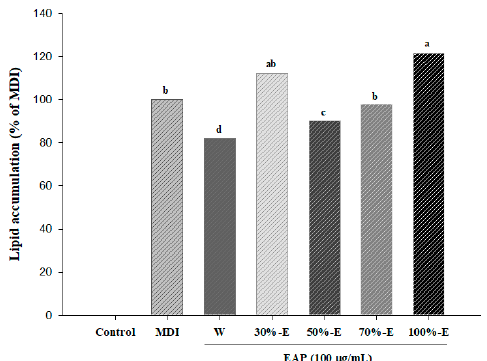
Figure 1. Effects of various extracts of EAP on lipid accumulation in 3T3-L1 adipocytes. EAP: Erigeron annuus (L.) Pers. water extract, Post-confluent 3T3-L1 preadipocytes were differentiated in the presence of various EAP extracts (water, 30% ethanol, 50% ethanol, 70% ethanol and 100% ethanol) for seven days. Lipid accumulation of cells was determined by Oil Red O (ORO) staining followed by reading absorbance at 490 nm. Values are presented as mean ± standard deviation. Differences between means were considered statistically significant at P < 0.05.